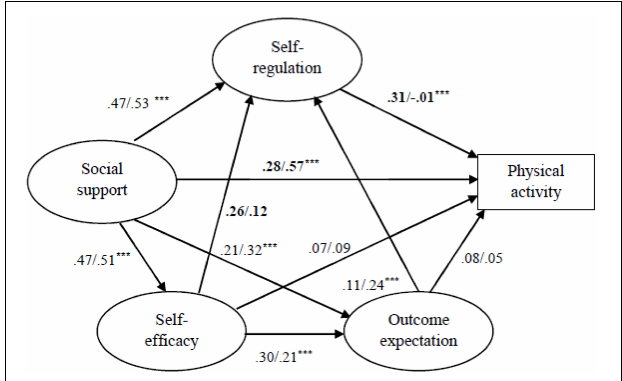
FIGURE 2 | The multigroup structural equation modeling (SEM) across urban and suburban. *** indicates p < 0.001, otherwise p > 0.05. Bold indicates significant differences of the path coefficients (critical ratios [CRs] >